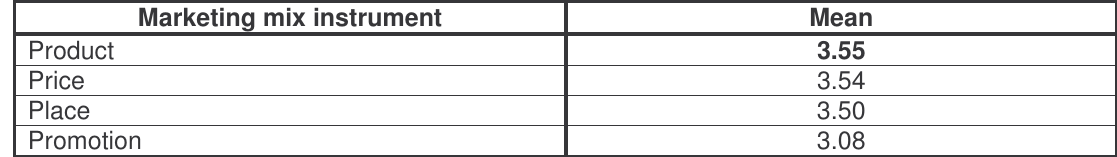
Importance of the traditional marketing mix-related aspects